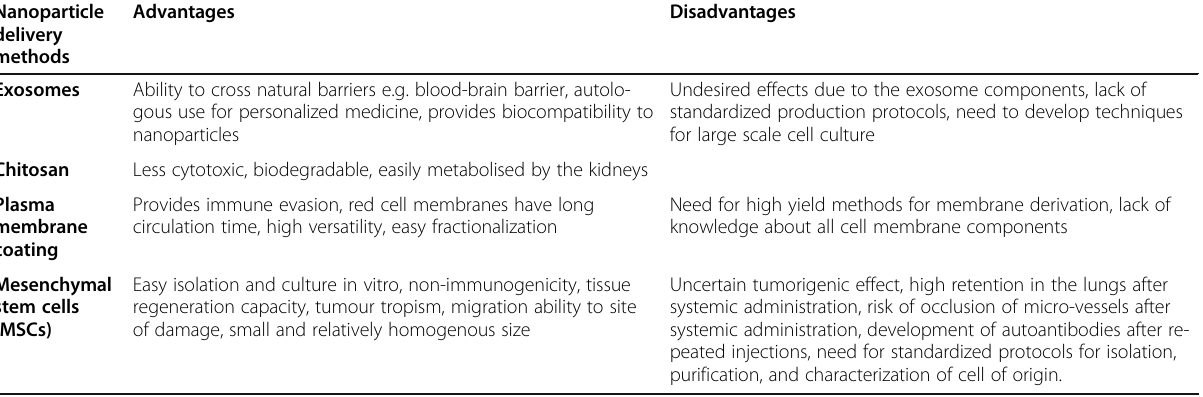
Table 2 Different delivery methods for nanoparticles Nanoparticle delivery